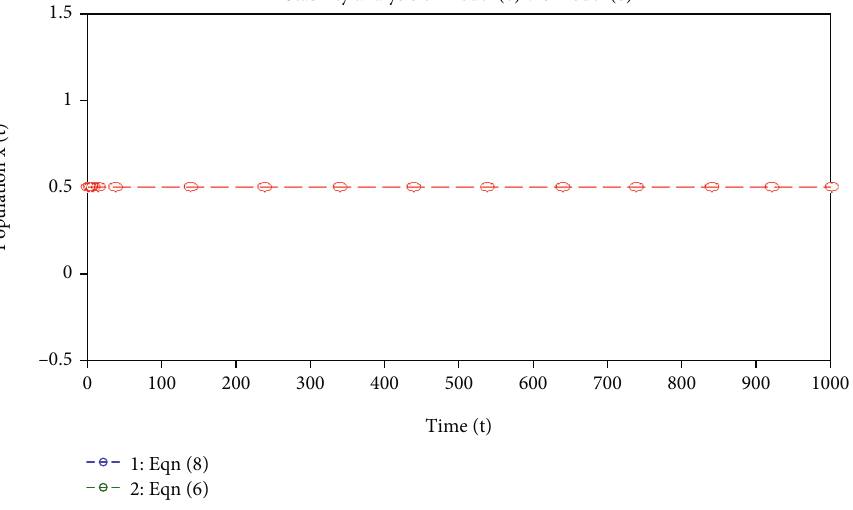
Figure 7: Stability analysis of equation (8) with r = 0 : 1 , τ = 3 : 00 , and h = 0 : 05 .